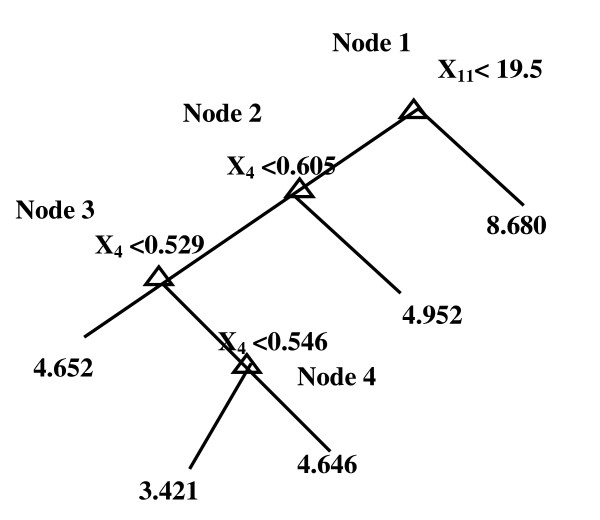
Optimal regression tree. Optimal regression tree with predictors [most contiguous base pair (X11) and target GC content (X4)] included in the model.